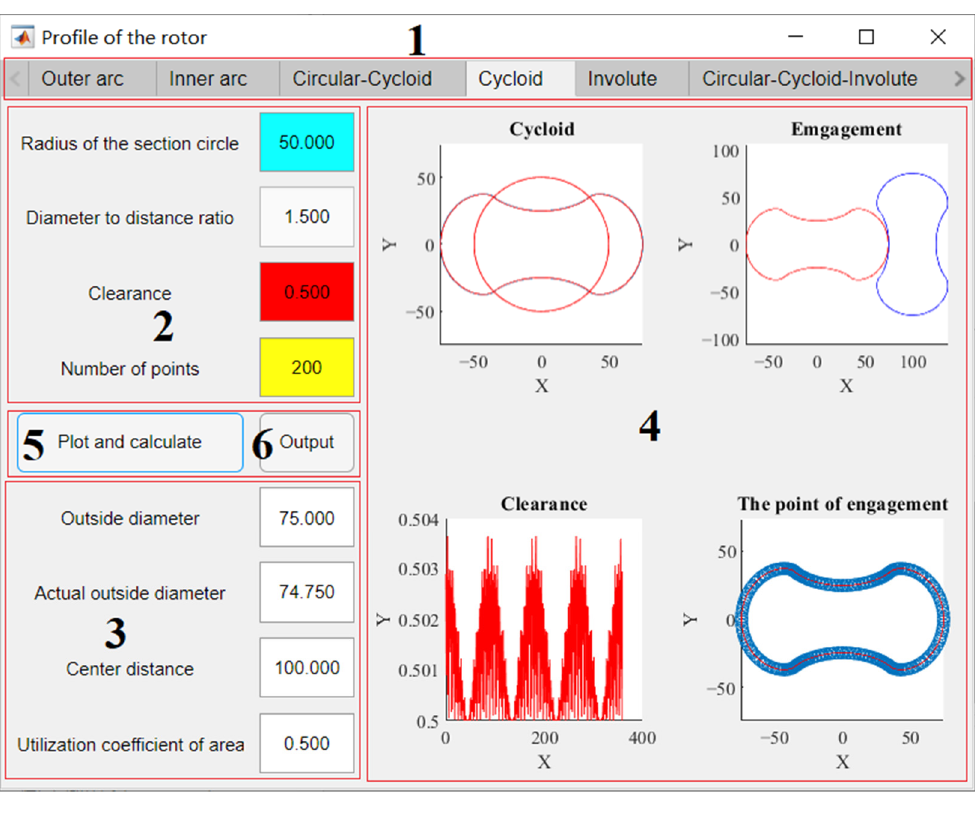
Figure 2. Roots pump profile generation program.